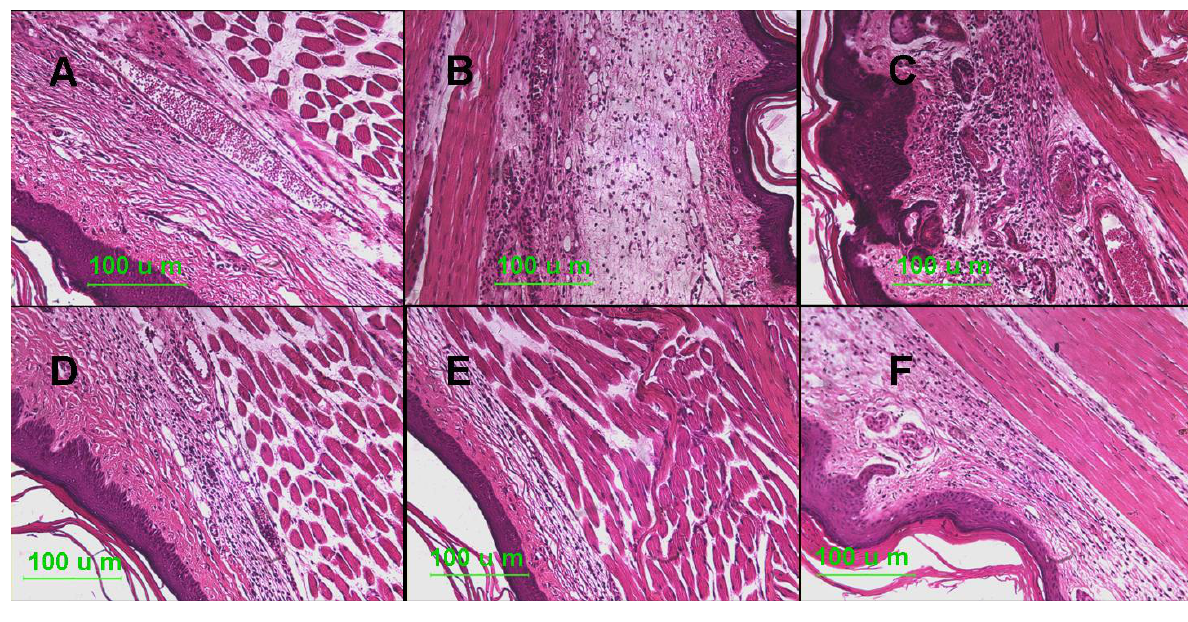
Figure 5. Histological changes in edema paws 5 h after injection of carrageenan. Paws were harvested 5 h after injection of carrageenan and subjected to histochemical staining of paw tissues. ( A ) Saline control group; ( B ) Carrageenan model group; ( C ) 4 mg/kg of 4-MCPC-treated group; ( D ) 8 mg/kg of 4-MCPC-treated group; ( E ) 16 mg/kg of 4-MCPC-treated group; and ( F ) 16 mg/kg of muscone-treated group; magnification